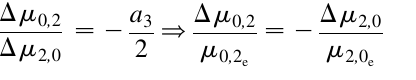
ffiffiffiffiffiffiffiffiffiffiffiffiffiffiffiffiffiffiffi